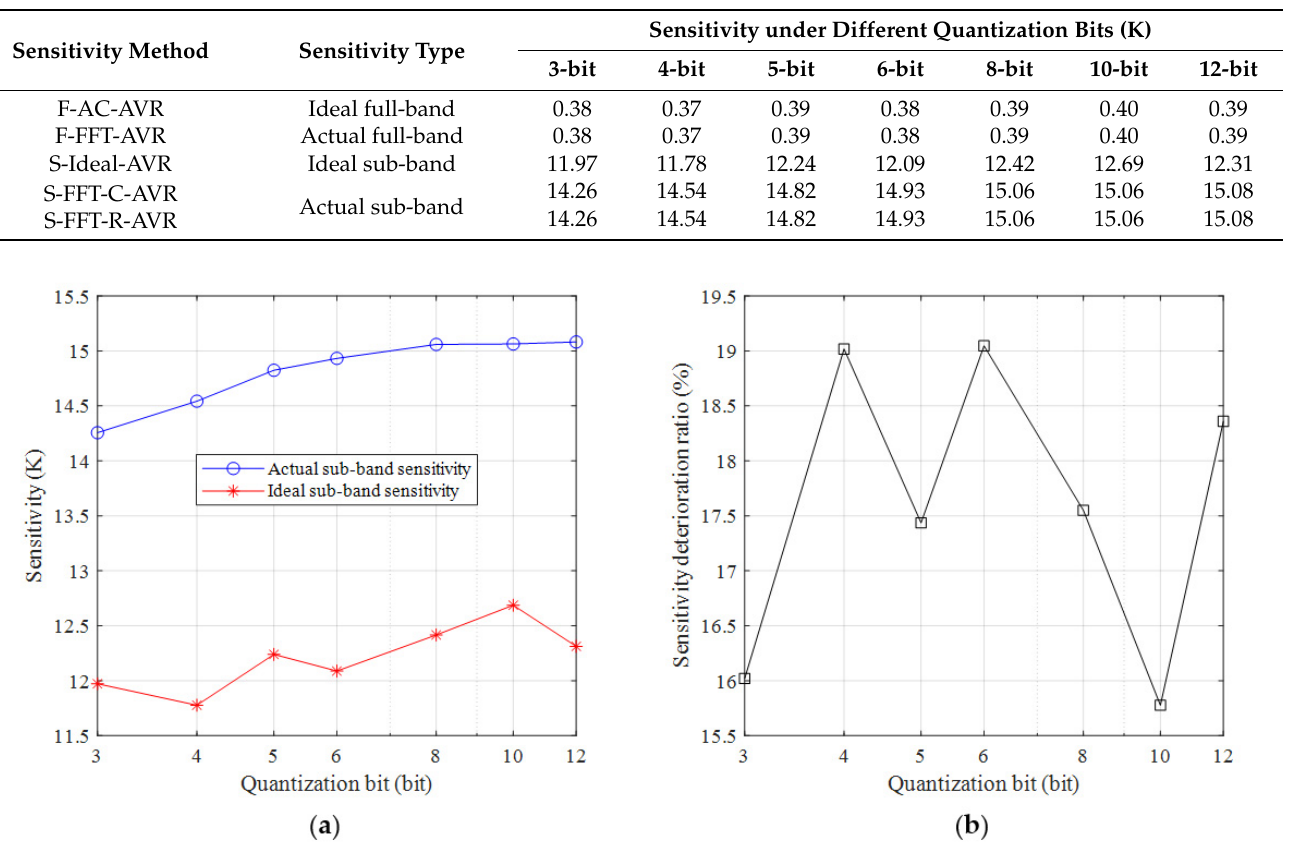
Figure 13. The sub-band sensitivity comparison and deterioration obtained by different spectral resolutions: ( a ) actual sub-band sensitivity and ideal sub-band sensitivity; ( b ) sub-band sensitivity deterioration ratio. Table 7. The average values of the sensitivity obtained by different quantization bits.